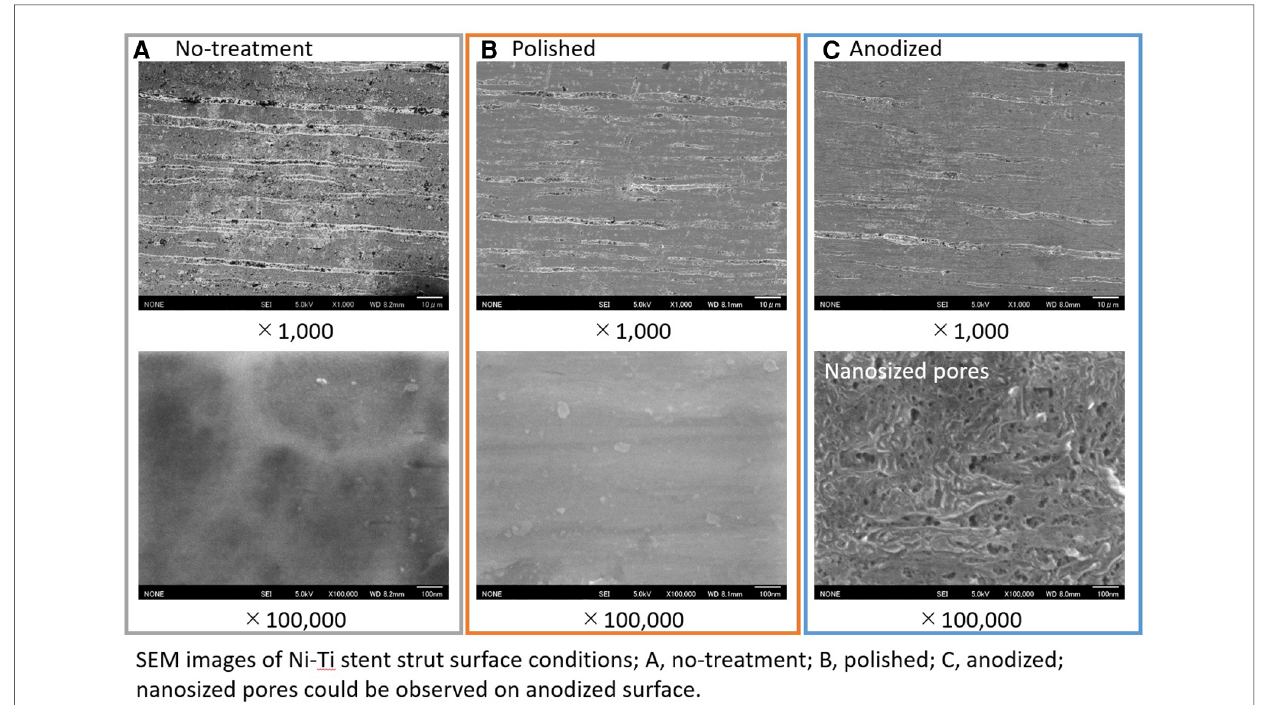
FIGURE 3 SEM images of stent strut surfaces; ( A ) no-treatment; ( B ) polished; ( C ) anodized.